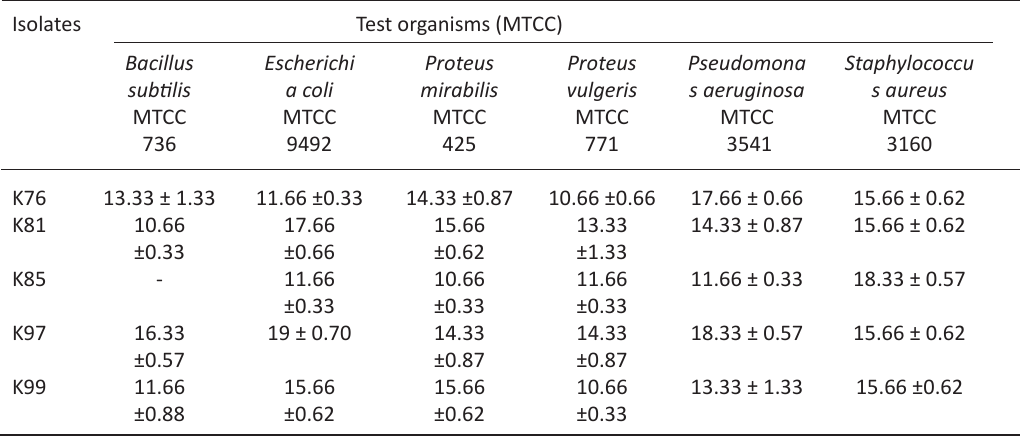
North East India and tested for their